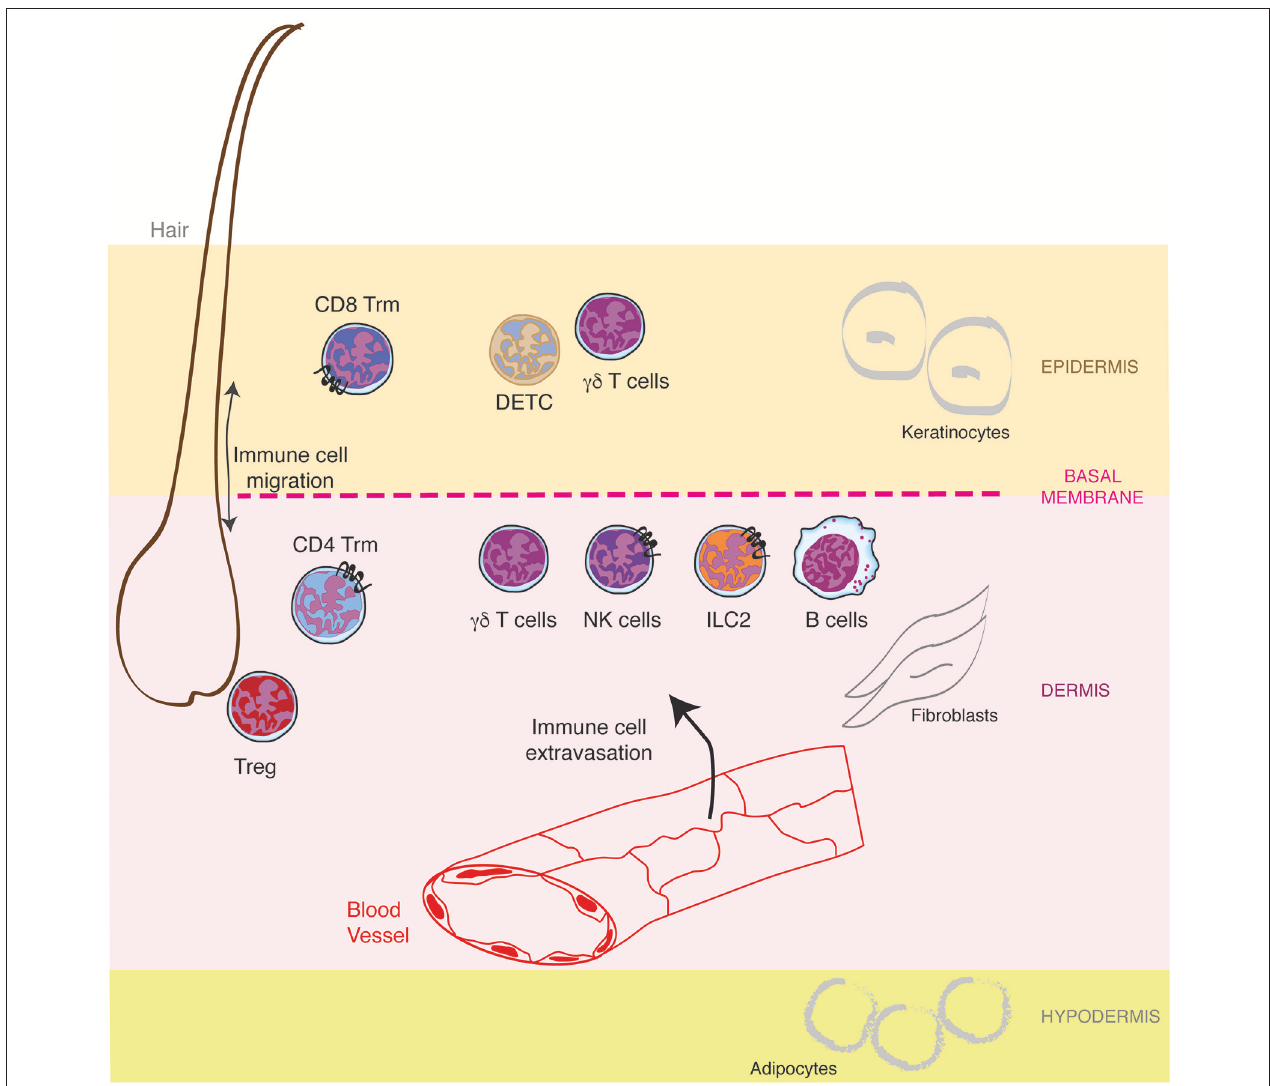
FIGURE 1 | Lymphocytes specific location in healthy skin. The skin is composed of a succession of three different layers, the epidermis, the dermis and the hypodermis populated by resident lymphocytes and lymphocytes recruited from the blood circulation through the cascade of molecular interactions. Furthermore, hair follicles represent a specific niche for some